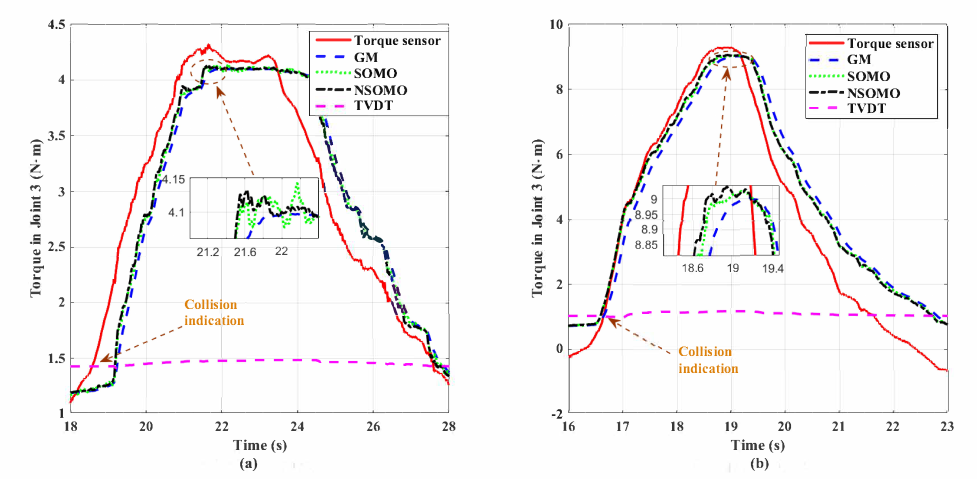
Figure 15. Comparison of the three observers with torque sensors in joint 3. ( a ) Balloon squeeze; ( b ) Squeeze by